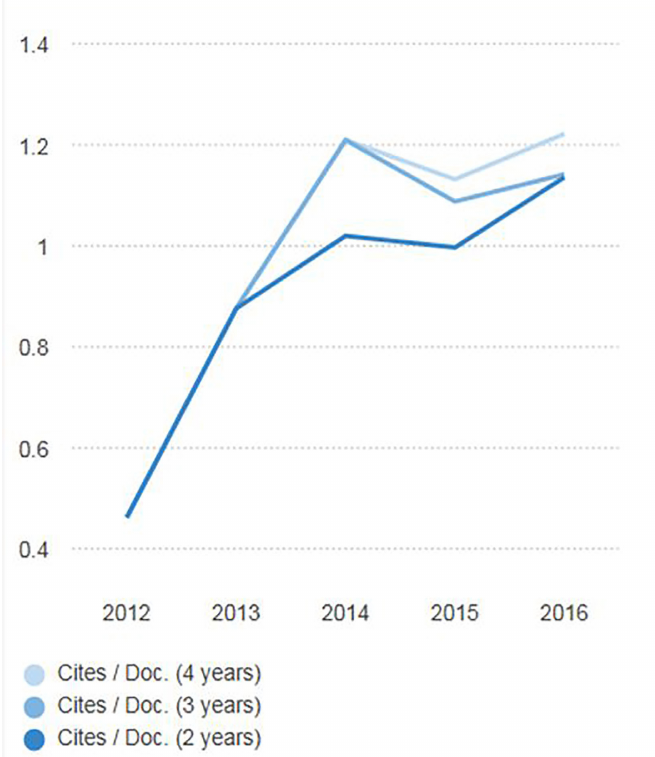
Figure 1. Trend of two- , three- , and four-year impact factor for Western Journal of Emergency Medicine . These are citations in index year of journal documents in previous two, three and four calendar years. Two-year impact factor is the same as Clarivate (formerly Thomson-Reuters) two-year impact